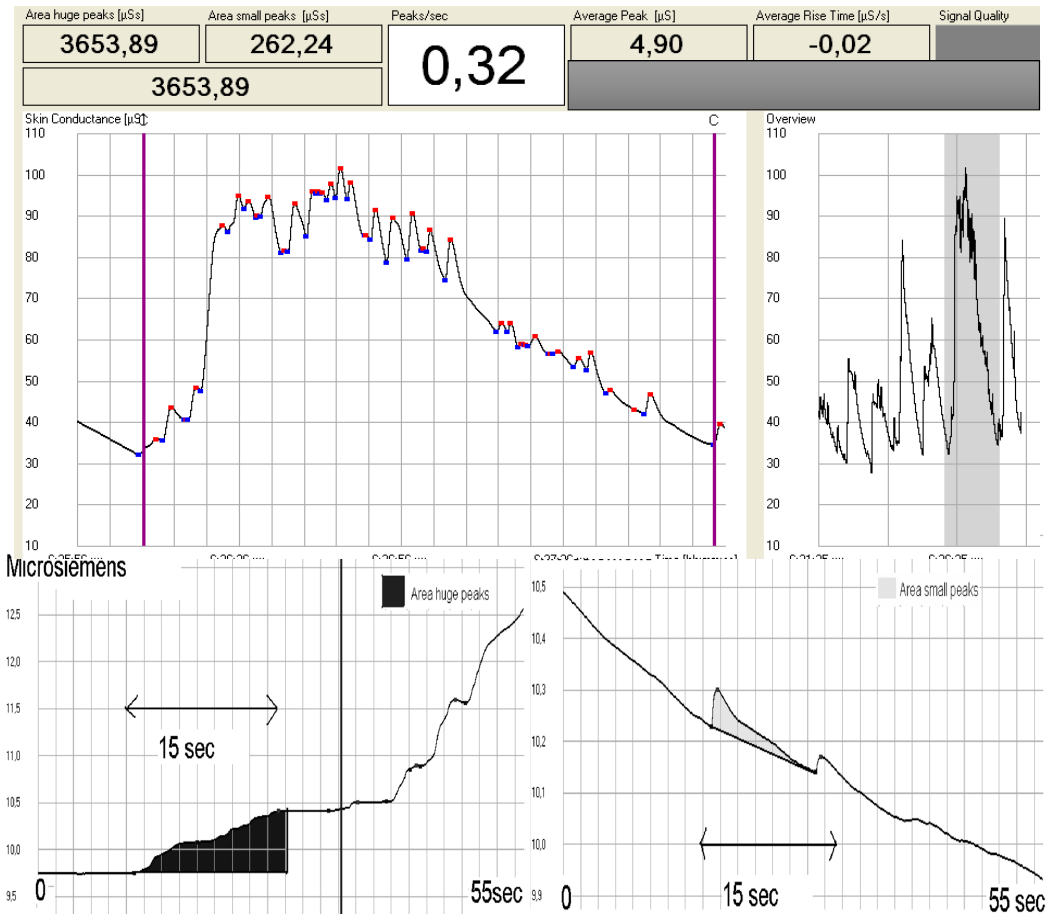
Figure A1. Sample measurements of EDA monitor as they appear in the monitor screen (decimals appear with “,”) (see text for details).